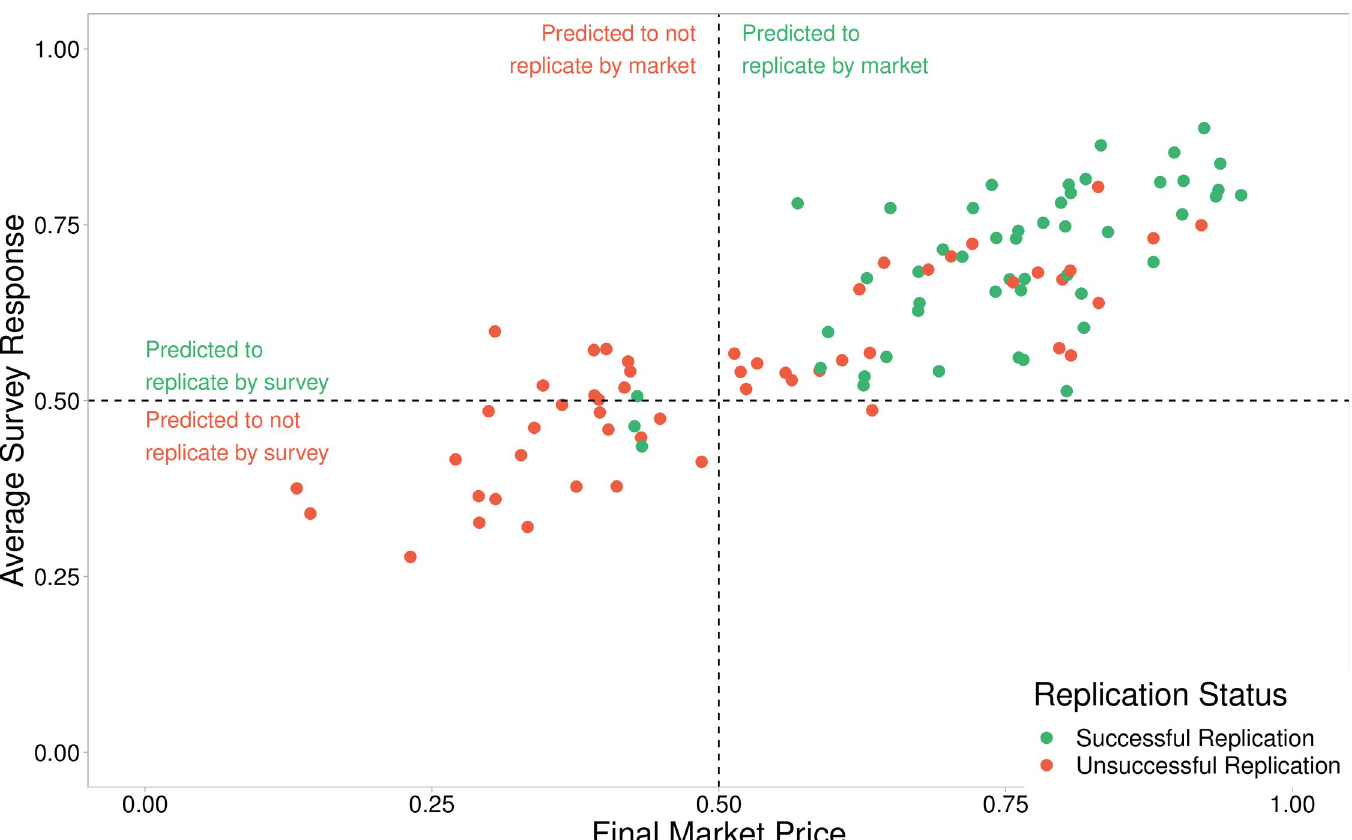
Fig 3. Market and survey correlations. Final Market Prices and average survey responses are highly correlated (rs(101) = .837, p < .001; r(101) = .853, p < .001). The dotted horizontal and vertical lines indicate the 0.5 cut off points used when applying a binary forecasting approach. The top left quadrant represents those findings which are predicted to replicate by survey but predicted to not replicate by market. The top right and bottom left quadrants contain findings where the markets and surveys agree, predicted to replicated and to not replicate respectively. The bottom right quadrant with a single finding, is where the study is predicted to replicate by the market but not by the survey. The colours of the findings show the replication outcome, with green indicating a successful replication outcome, and red indicating unsuccessful